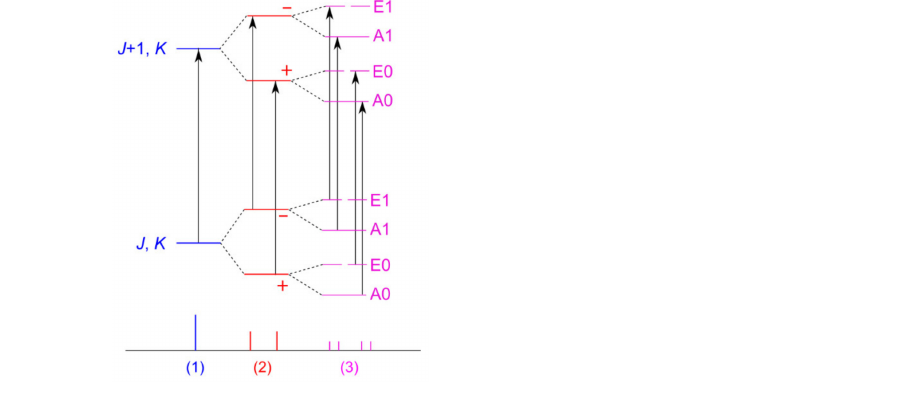
Figure 19. Non-scaled energy levels and microwave signal splittings for molecules featuring one two-fold tunneling motion and a methyl internal rotation, case (3), as in phenyl acetate with